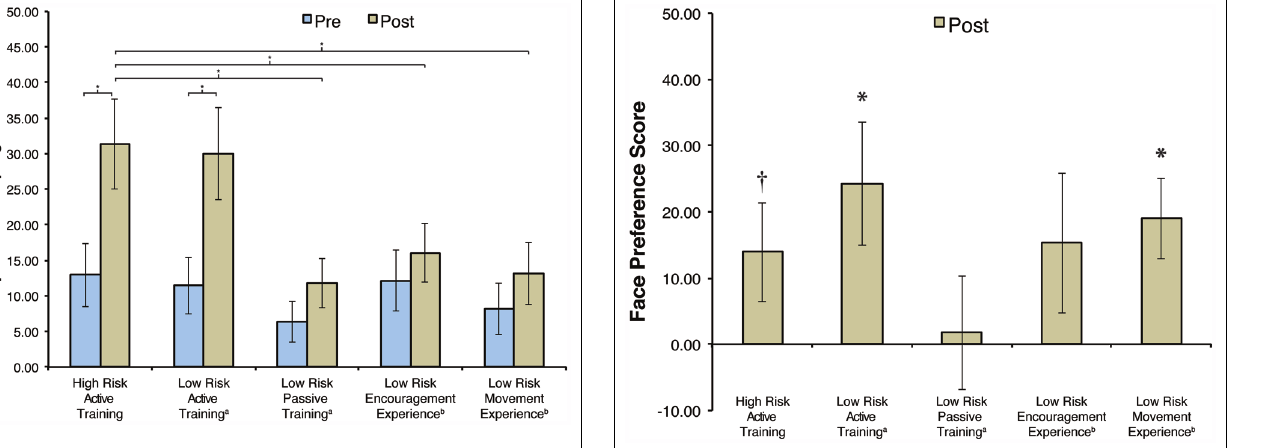
different sized screens (17 (cid:2)(cid:2) vs. 22 (cid:2)(cid:2) ) between HR and LR